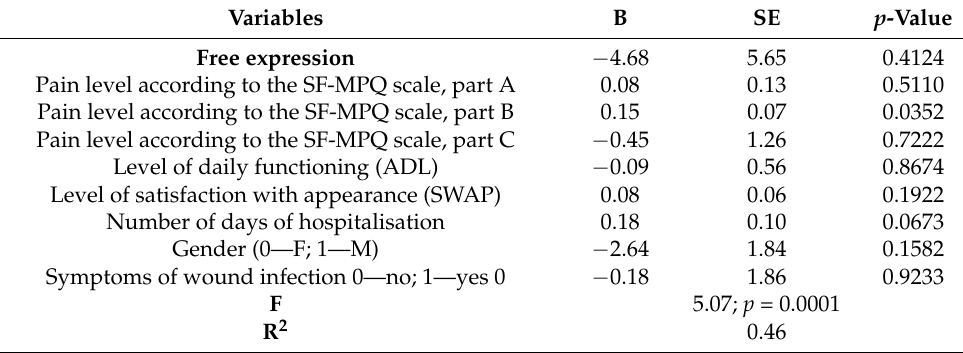
Table 4. Factors influencing the level of depressive symptoms (BDI scale) in the subjects—multiple regression results. Variables B SE p -Value Free expression − 4.68 5.65 0.4124 Pain level according to the SF-MPQ scale, part A 0.08 0.13 0.5110 Pain level according to the SF-MPQ scale, part B 0.15 0.07 0.0352 Pain level according to the SF-MPQ scale, part C − 0.45 1.26 0.7222 Level of daily functioning (ADL) 0.08 0.06 0.1922 Number of days of hospitalisation 0.18 0.10 0.0673 Gender (0—F; 1—M) − 2.64 1.84 0.1582 Symptoms of wound infection 0—no; 1—yes 0 − 0.18 1.86 0.9233 F 5.07; p = 0.0001 R 2